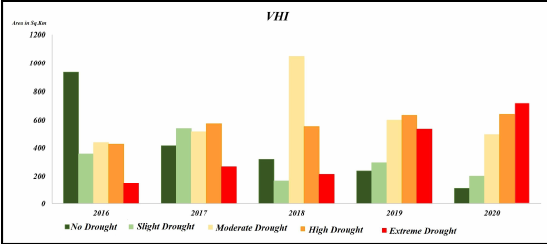
Figure 11: Graphical representation of VHI classes for consecutive years (2016-2020) Eventually, the spatio-temporal analysis of the VHI results exemplifies that the area of healthy vegetation and no drought